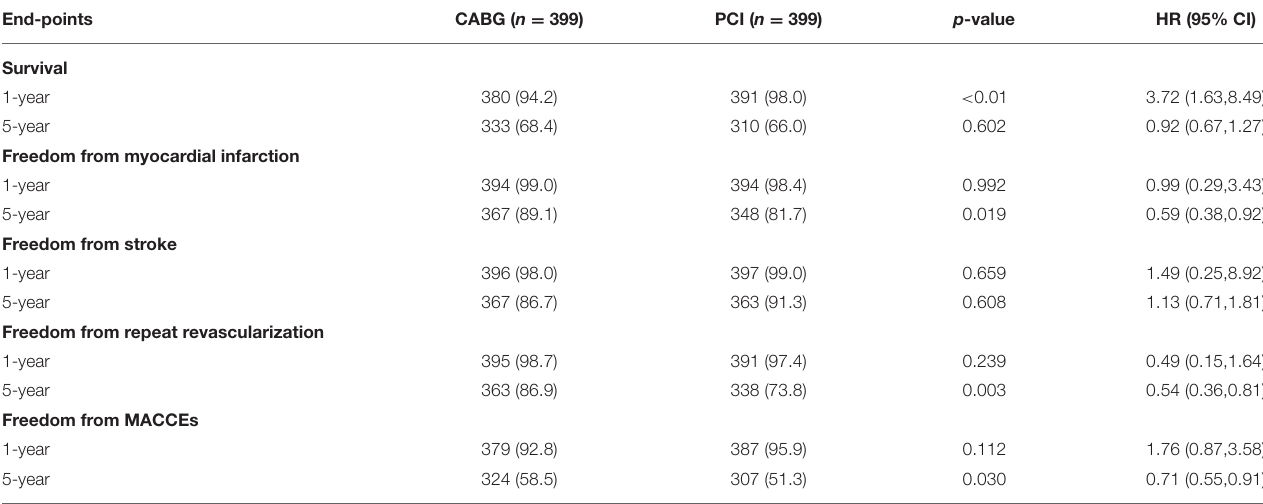
TABLE 3 | Comparison of follow-up data between PCI and CABG groups after propensity score matching.